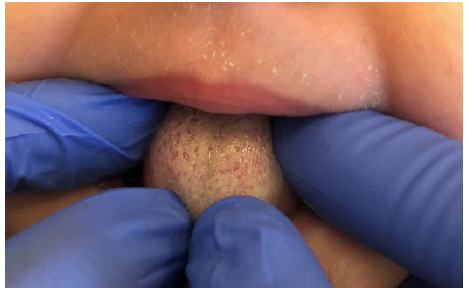
Figure 6. Lingua villosa on the dorsum of the tongue in the female infant. HT is characterized by elongated filiform papillae, especially in the midline and anterior part of the dorsum of the tongue.